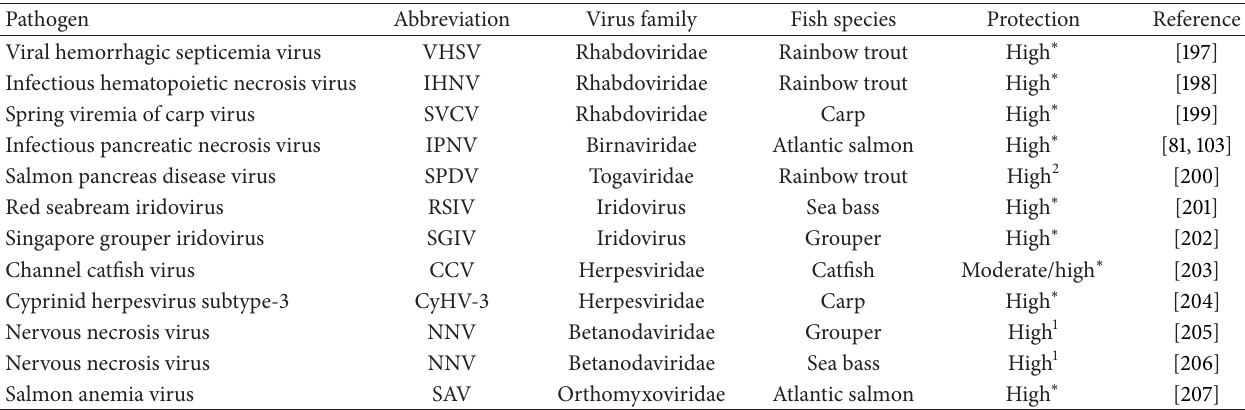
Table 5: Inactivated whole virus vaccines explored in fish.